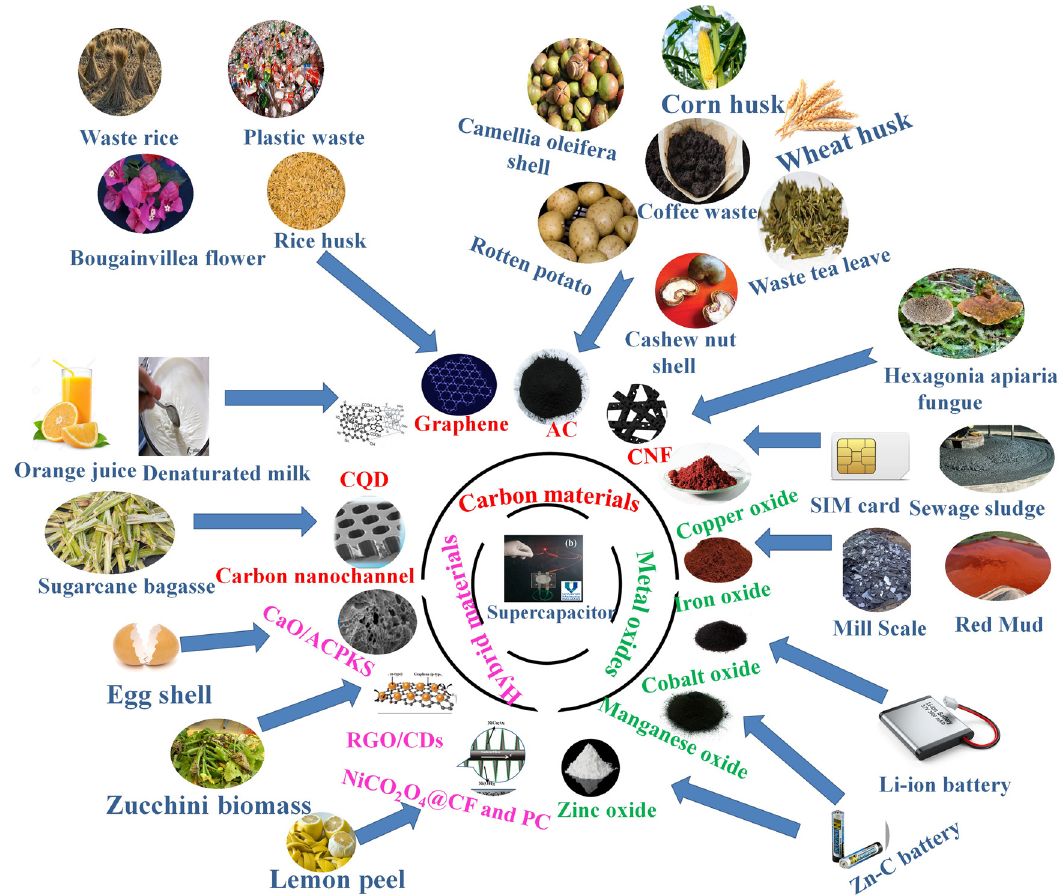
Figure 36: Schematic of the main waste sources used to fabricate supercapacitor electrode